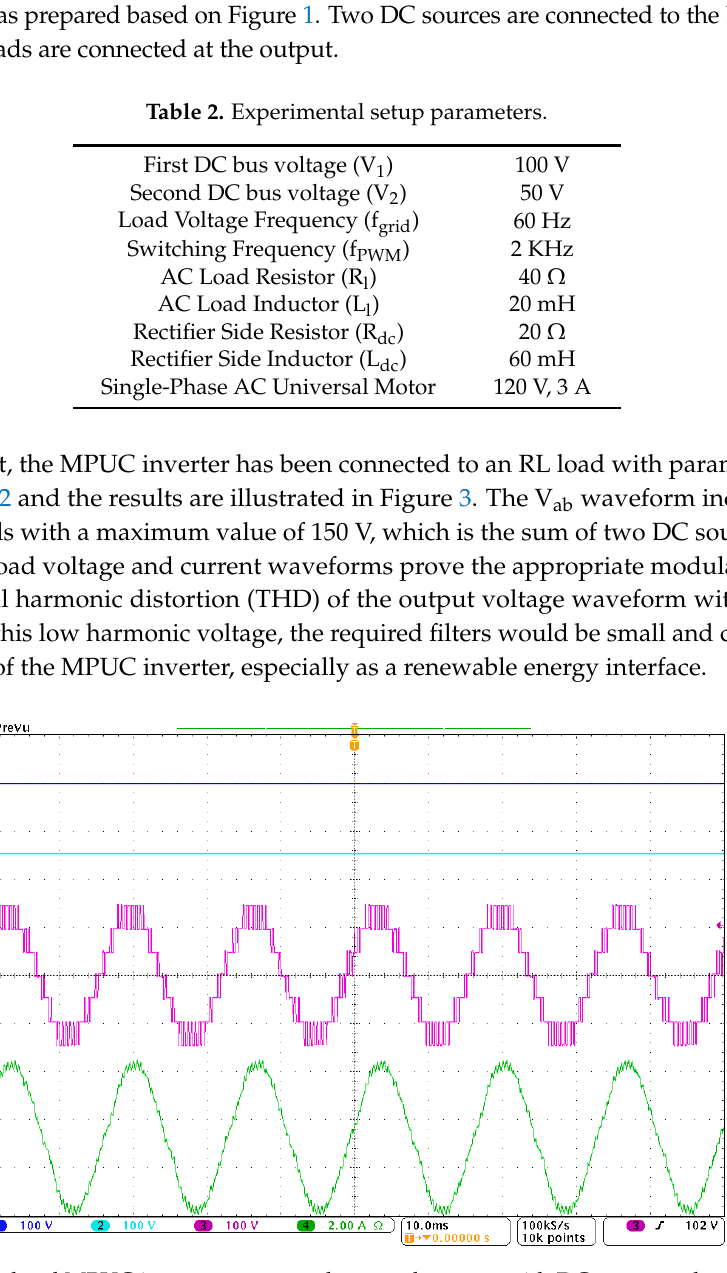
Table 2. Experimental setup parameters.